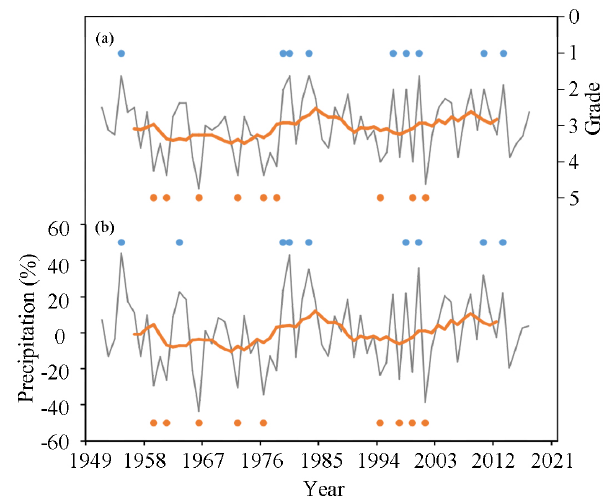
Figure 3. The comparison of drought and flood grades (a) and pre- cipitation anomaly percentage (b) in the HRB during 1951–2017. Blue dots indicate extreme flood years, and orange dots indicate ex- treme drought